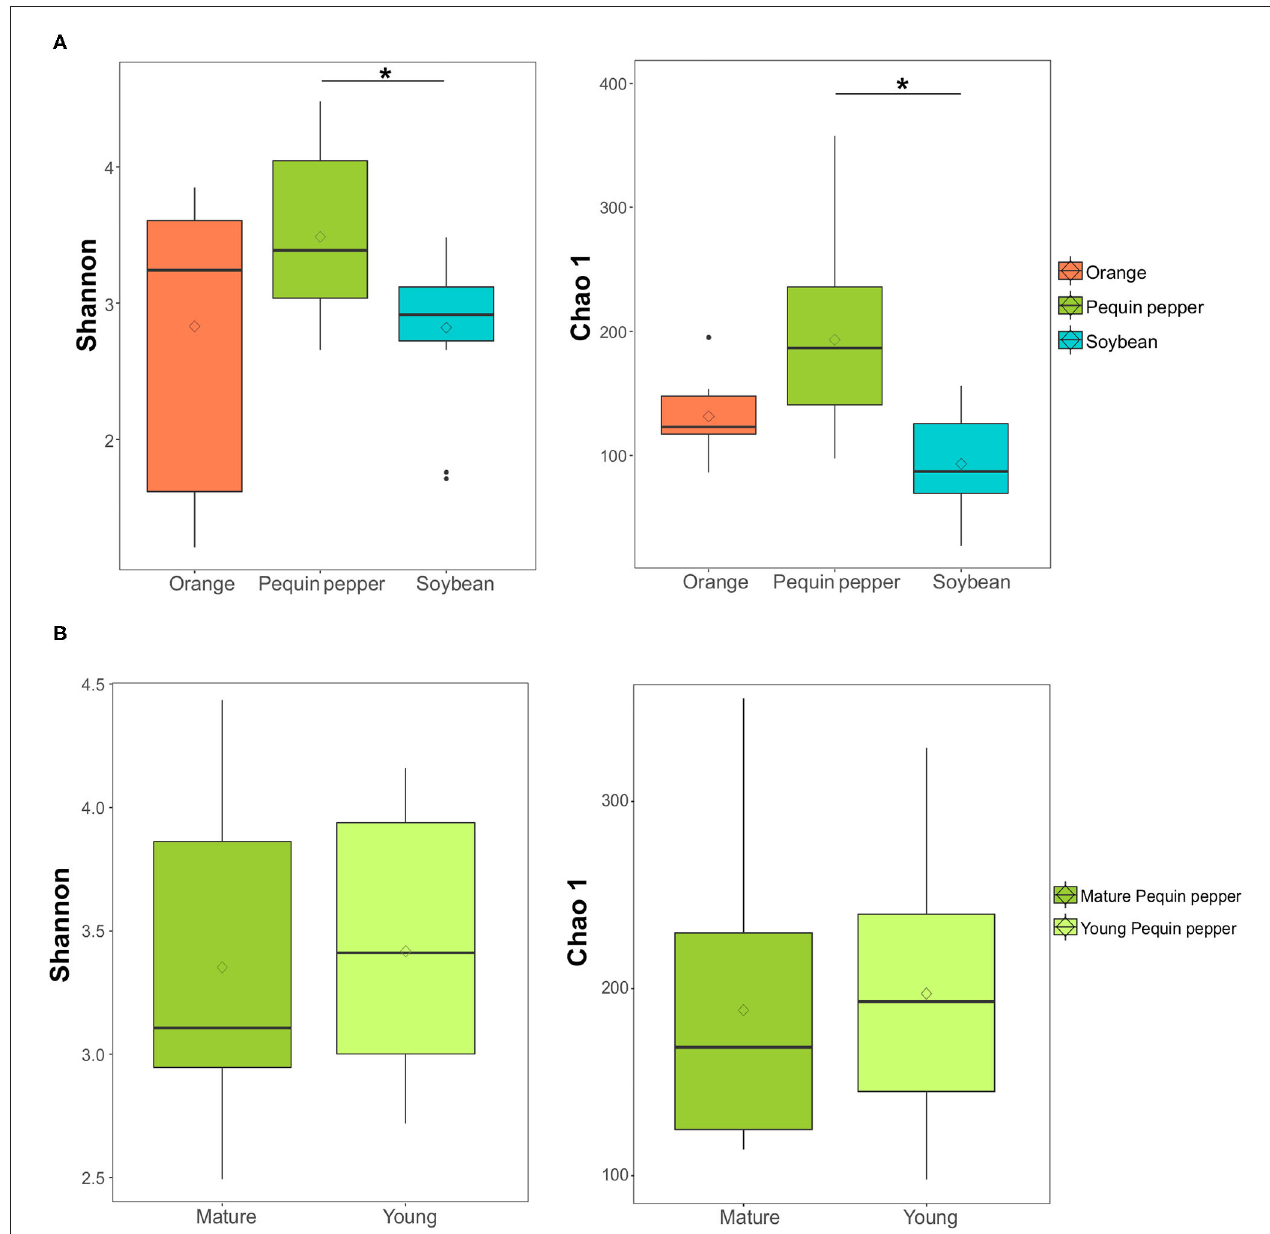
FIGURE 3 | Differences in diversity and richness among crops. (A) Boxplots of Shannon diversity index and Chao1 richness index of crops, and (B) of mature and young Pequin pepper. Statistically significant differences (Kruskal-Wallis test, P -value < 0.05) are represented by *. Diamonds represent the average and thick black lines the